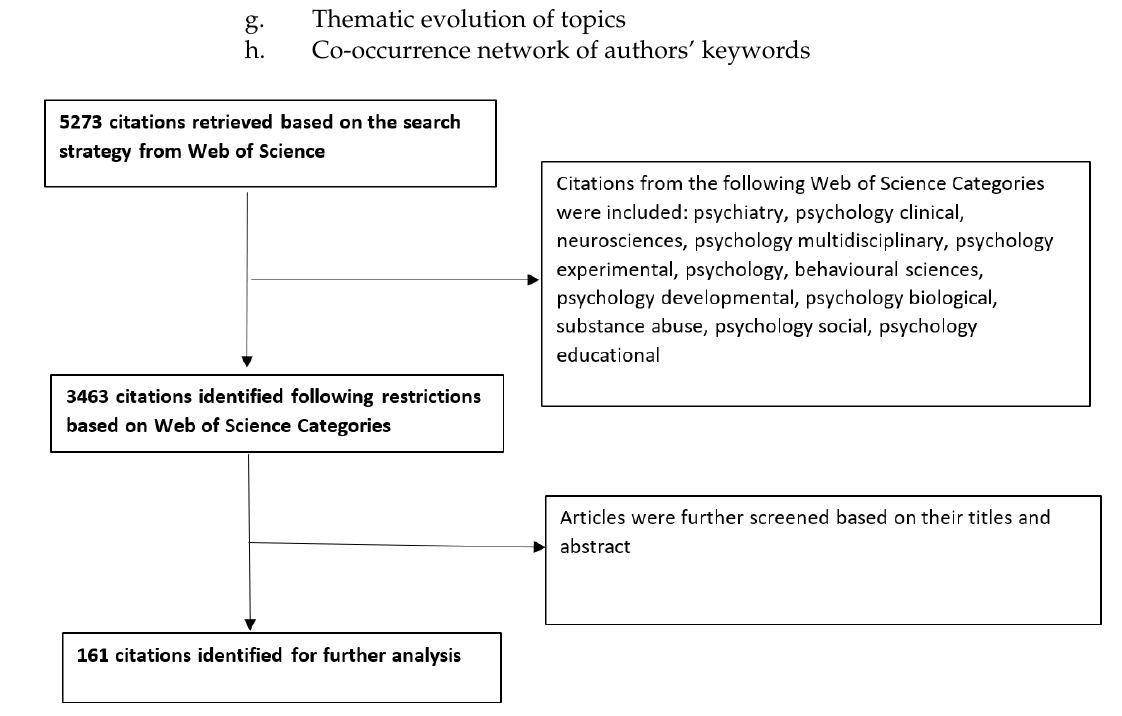
Figure 1. A flowchart of how studies were selected.